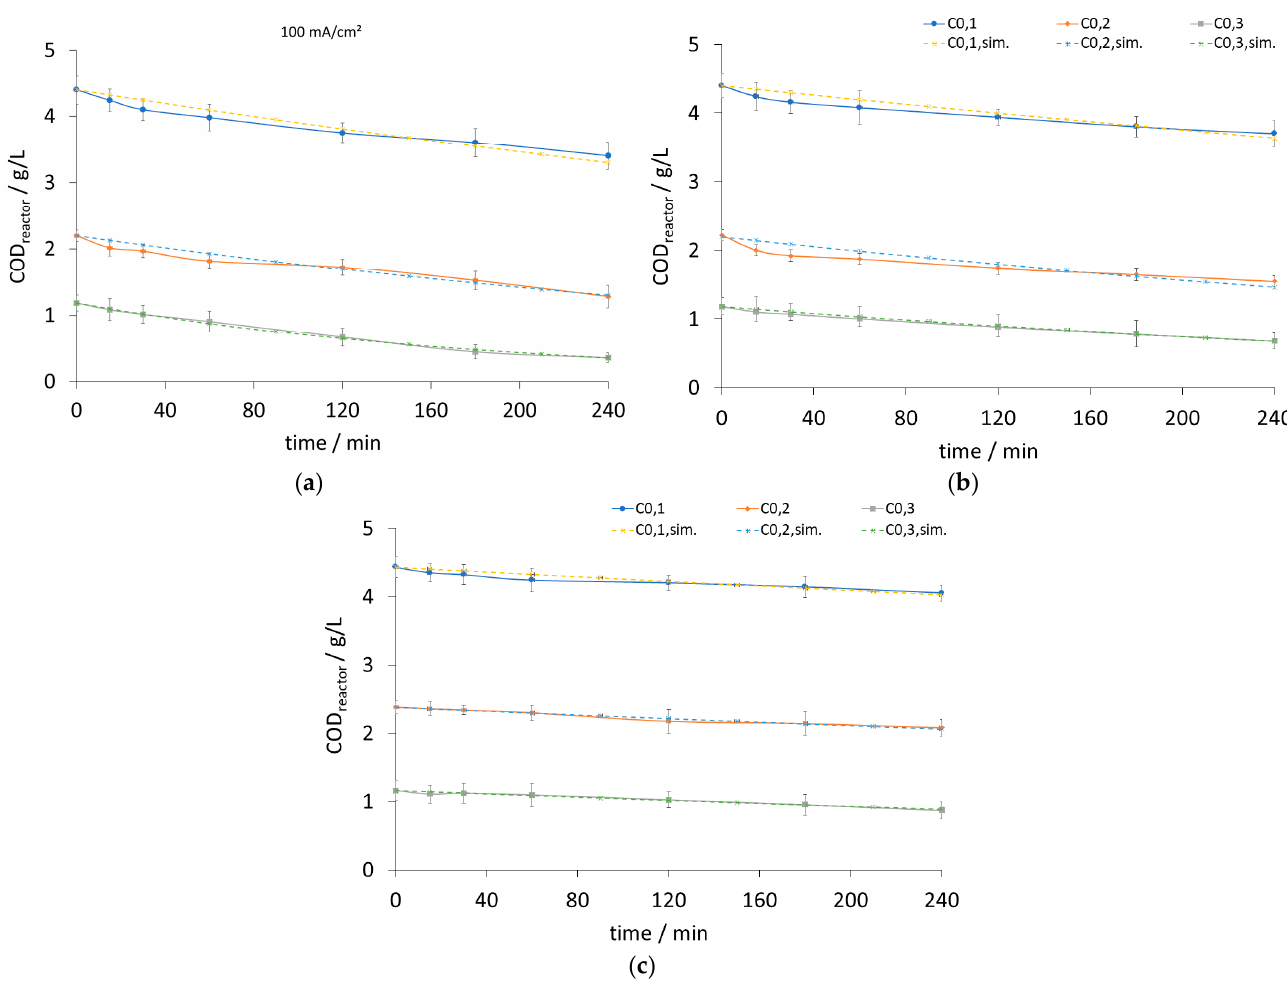
Figure 4. ( a – c ) COD concentration decrease at different current densities. The continued line is the measured value during the experiments. The dotted line is the theoretical value based on the rate constant calculated from measured values.